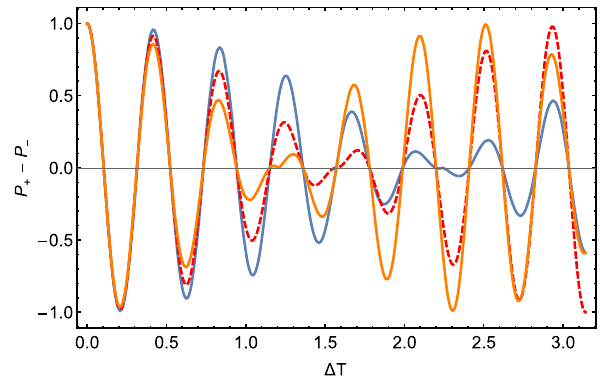
Fig. 5 Behavior of the detection probabilities (53) in Einstein’s GR (dashed red line), R 2 -gravity (orange solid line) and analytic nonlocal gravity (blue solid line). Since we are only interested in the qualitative behavior of the decoherence, in the plot we have magnified the differ- ences between the three cases under examination; for this reason we have rescaled (cid:14) T so as to render it dimensionless. Moreover, to